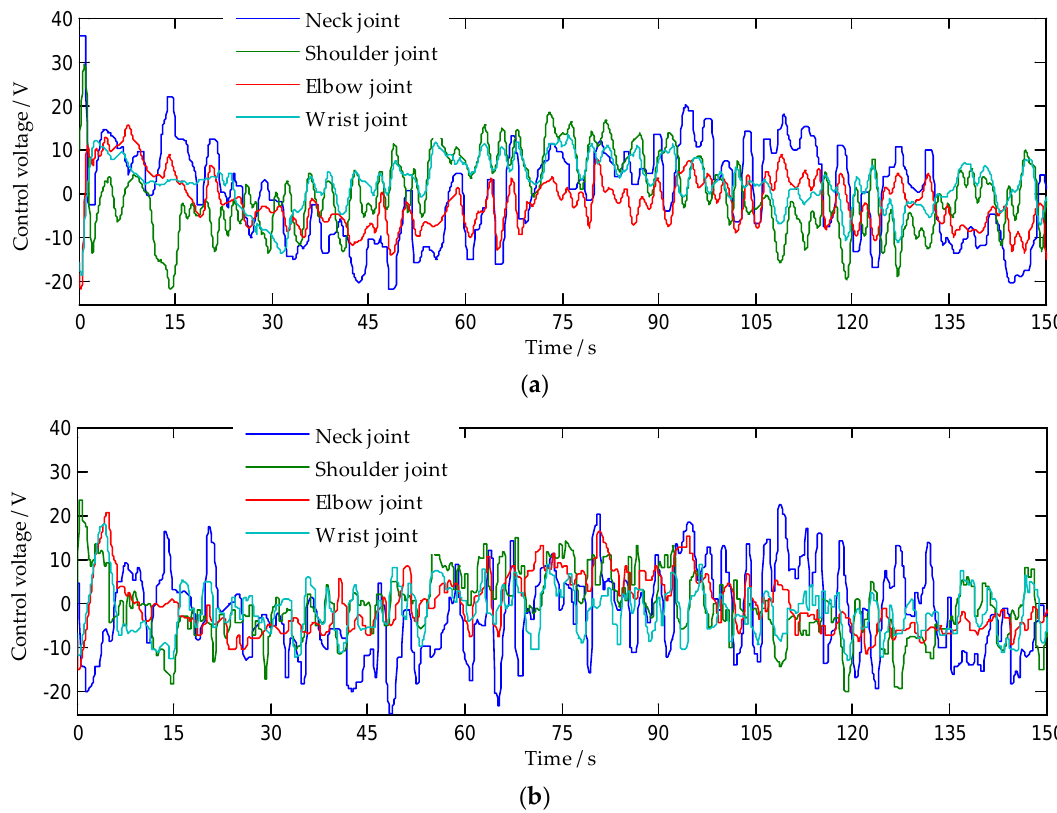
Figure 5. The comparison data of joint control voltages of underwater manipulators. ( a ) The control voltages of the proposed method and ( b ) the control voltages of the method in [17].